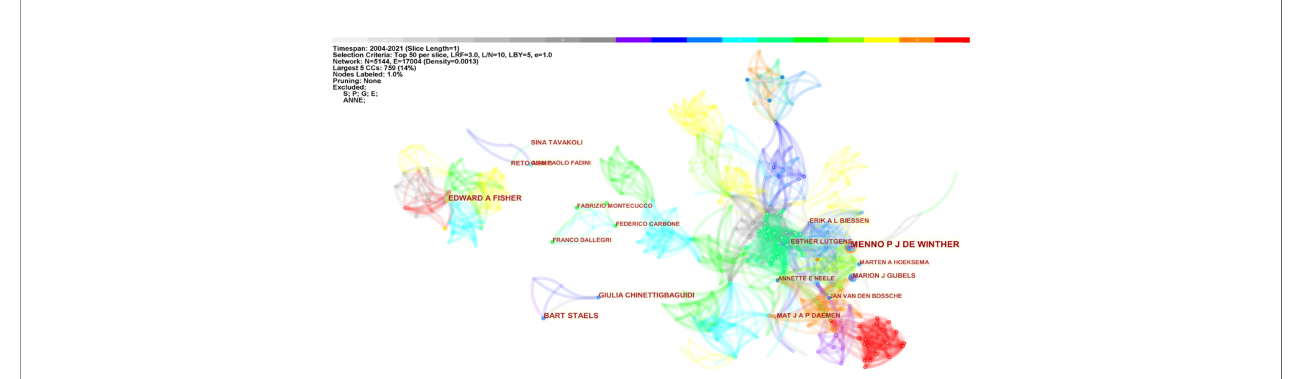
FIGURE 2 | Author co-occurrence map of macrophage polarization in AS research (K = 5).